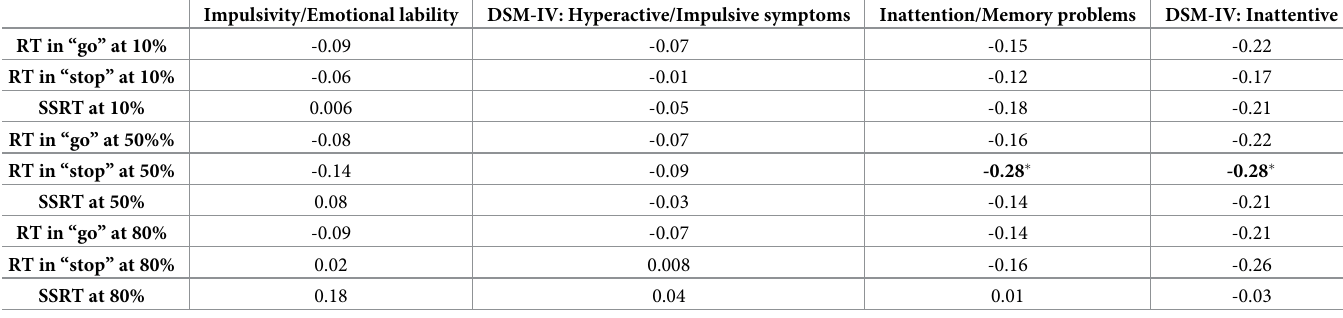
Table 3. Values of Spearman’s ρ for correlations between keypress measures and impulsivity/inattention measures at different coherence levels. Impulsivity/Emotional